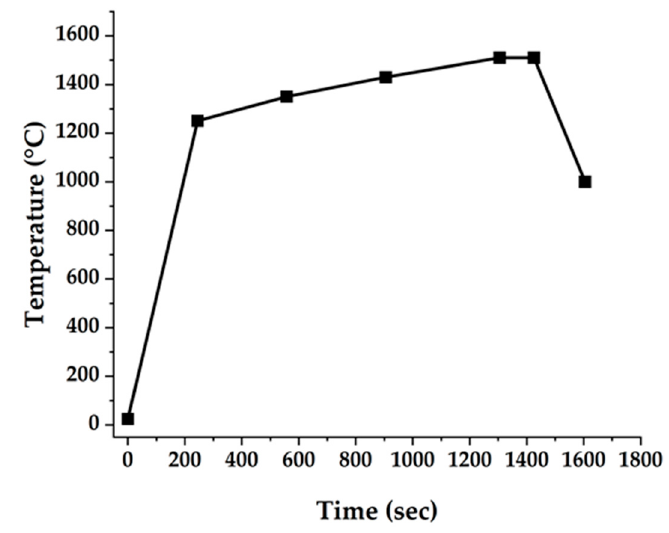
Figure 2. Sintering schedule.